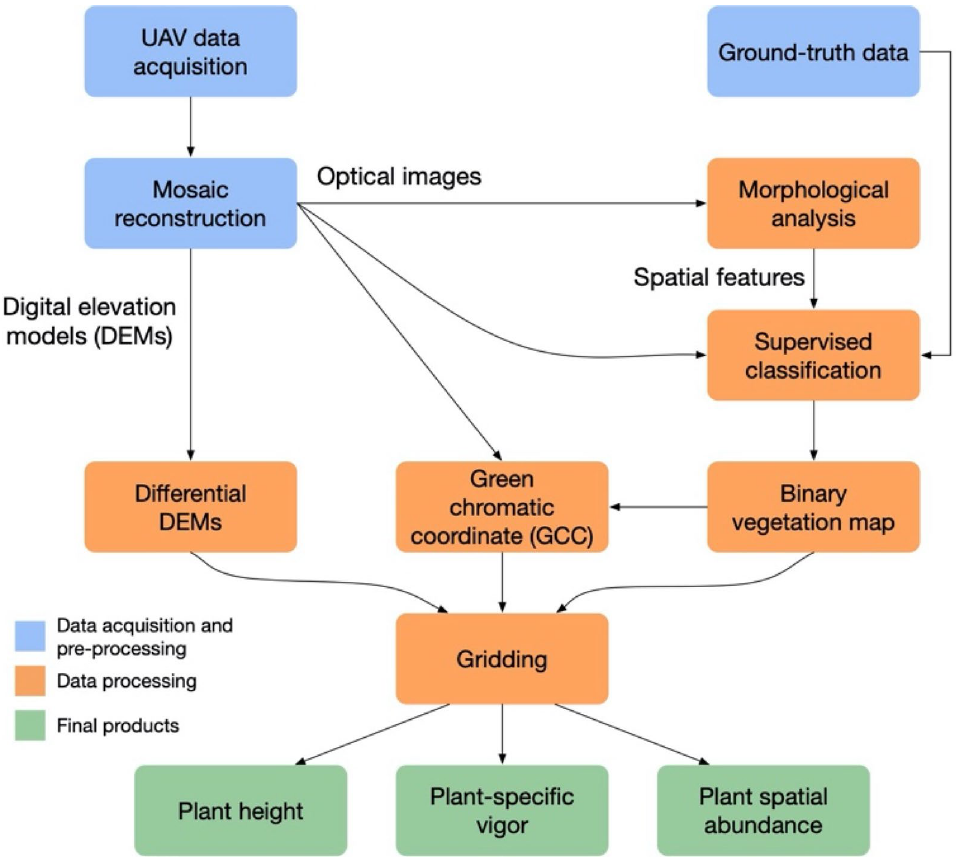
Figure 2. Pipeline developed for the UAV data